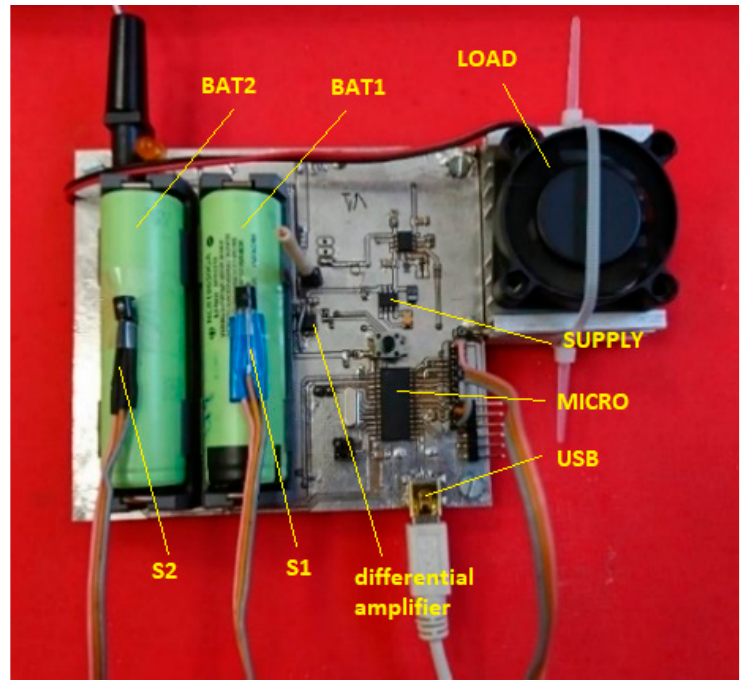
Figure 7. The SWD appearance during switched discharge.